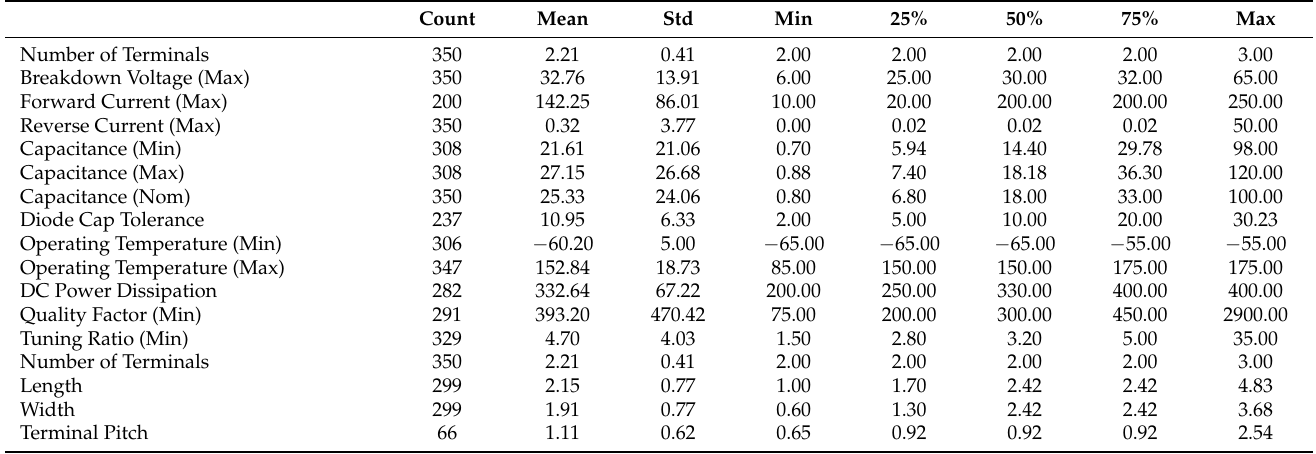
Table 4. Statistics for the features of varactors.